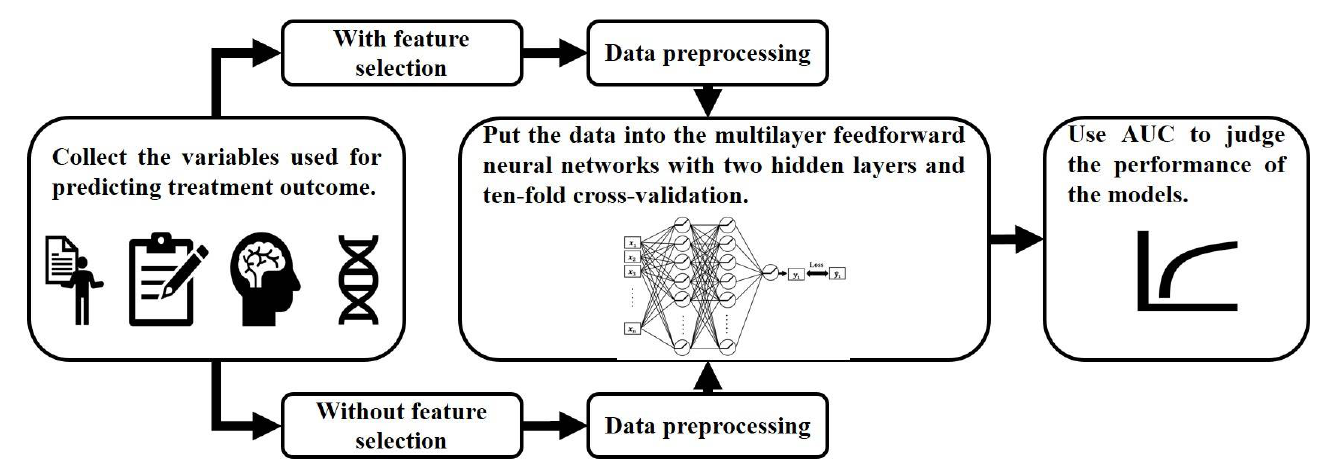
Figure 2. The procedure to construct multilayer feedforward neural networks for predicting the treatment outcome.